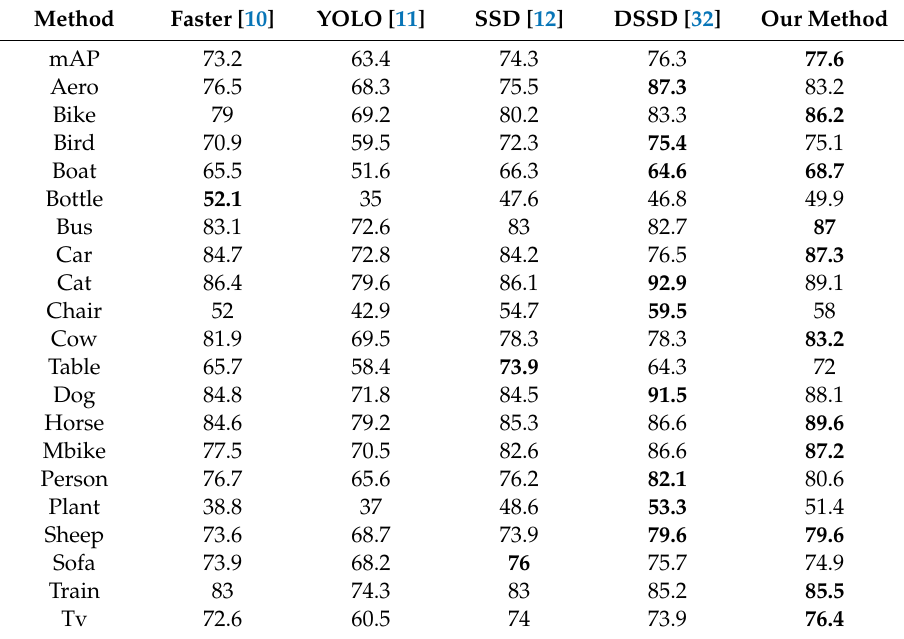
Table 1. PASCAL VOC detection